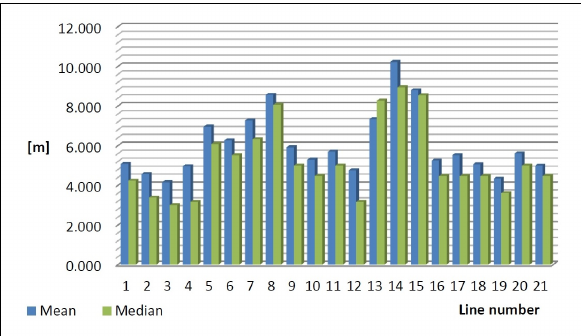
Figure 6. Mean and median histogram for the test site Austria